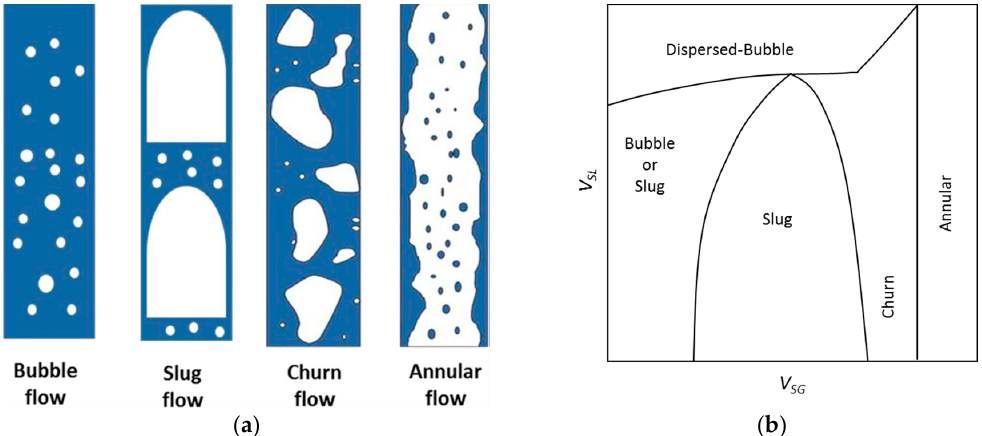
Figure 7. Typical flow patterns and transition boundaries in vertical pipe, ( a ) main observed flow patterns [54]; ( b ) transition boundaries and flow pattern map [52].